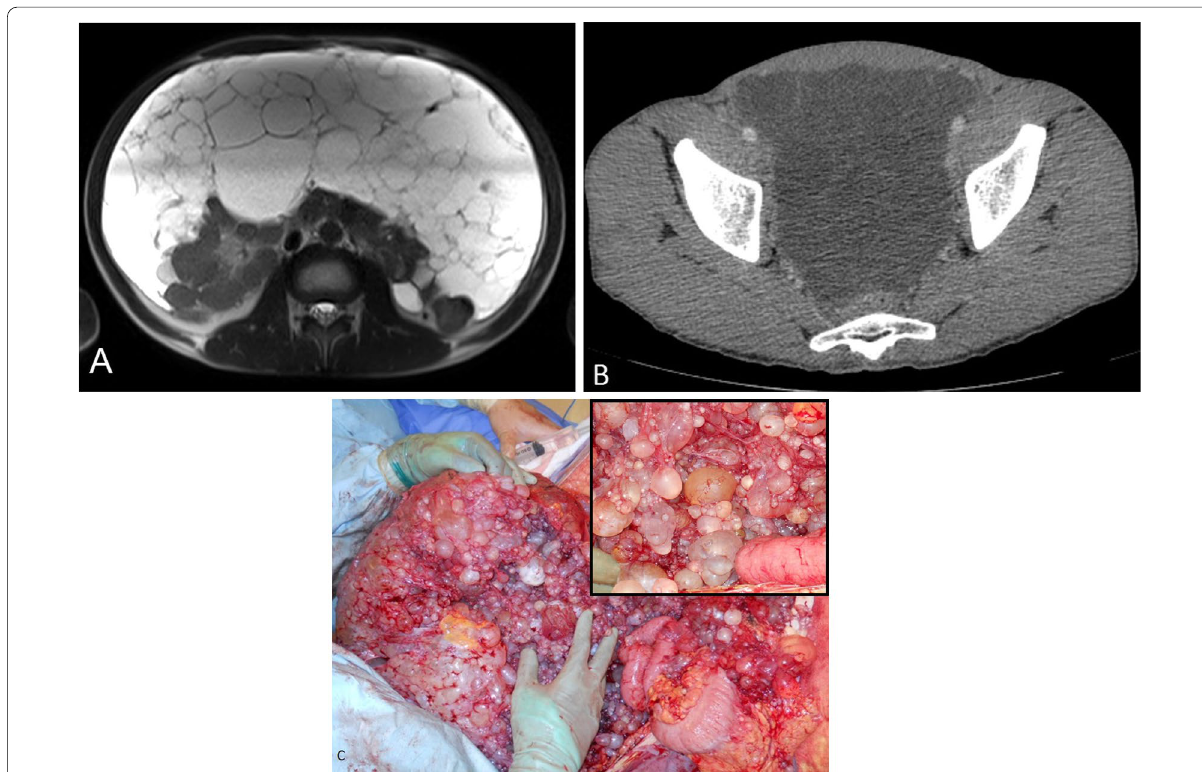
Fig. 2 a – c 42-year-old male with diffuse form of cystic mesothelioma. a MRI T2 weighted axial image shows diffuse multi-cystic lesions in the peritoneal cavity. b CT through the pelvis shows fluid attenuation cystic lesions with fine non-enhancing septations. c Intra-operative photograph shows diffuse multi-loculated cystic masses in the diffusely filling the peritoneal cavity